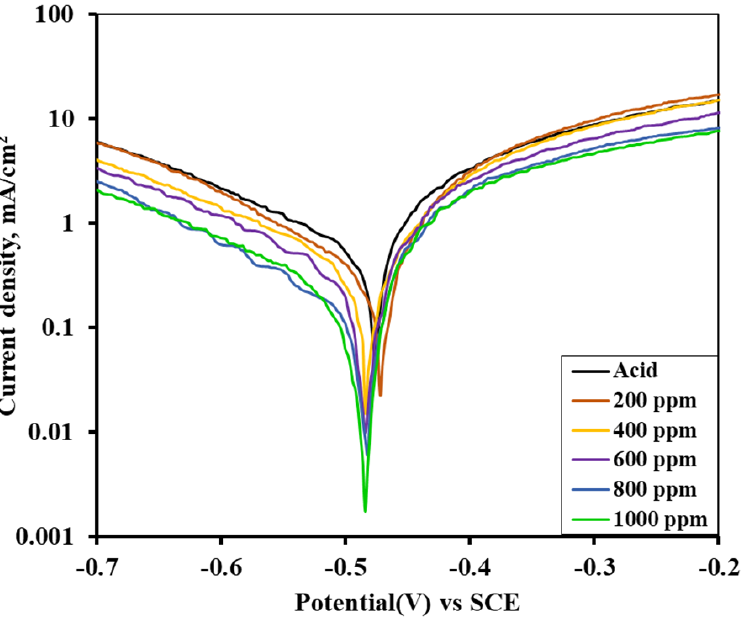
Figure 12. Potentiodynamic polarization curves for MS in 1 M H 2 SO 4 containing different concentra- tions of AV alkaloid for 1 h immersed sample.